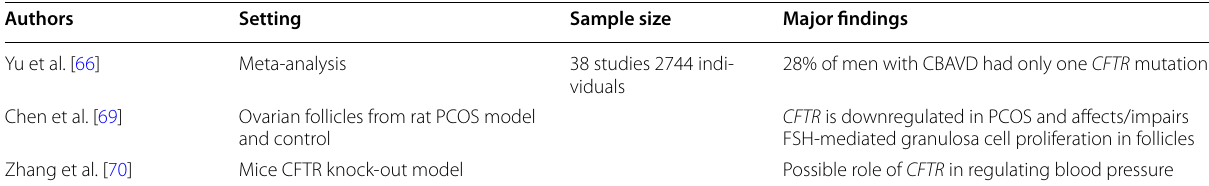
Table 4 Summary of main studies about CFTR and reproductive system